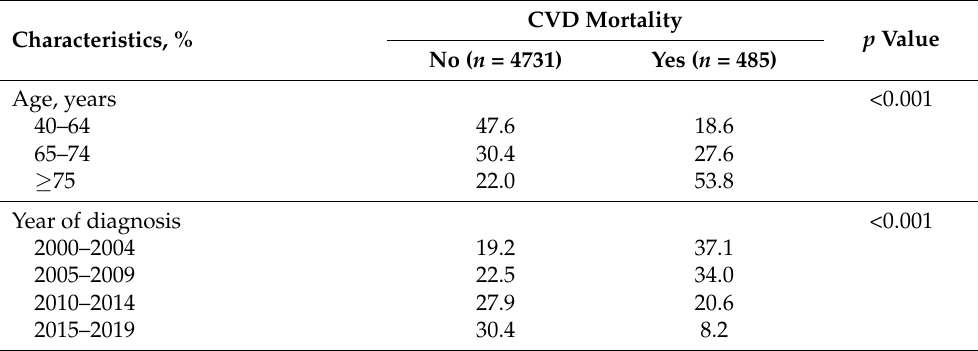
Table 2. Characteristics of men at the time of breast cancer diagnosis according to cardiovascular disease mortality status at the end of follow-up, SEER registry ( n =